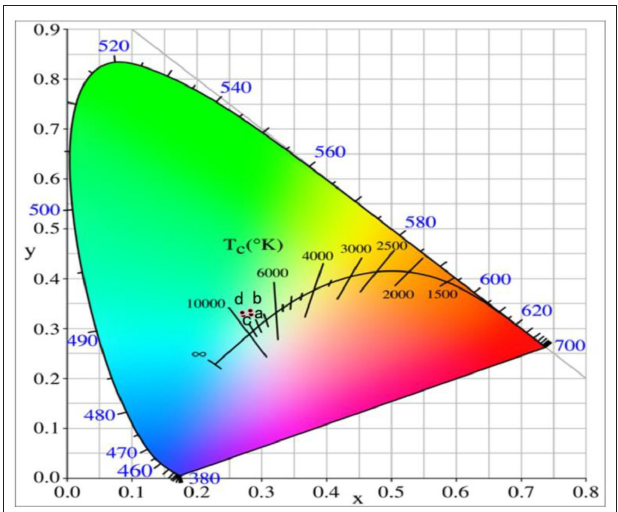
FIGURE 9 | Chromaticity coordinates of the GdAlO 3 : 0.6%Er 3 + , 16%Yb 3 + , 1%Tm 3 + phosphor under excitation at 980nm with different laser powers (a:197 mW, b:253 mW, c:310 mW, d:366 mW).